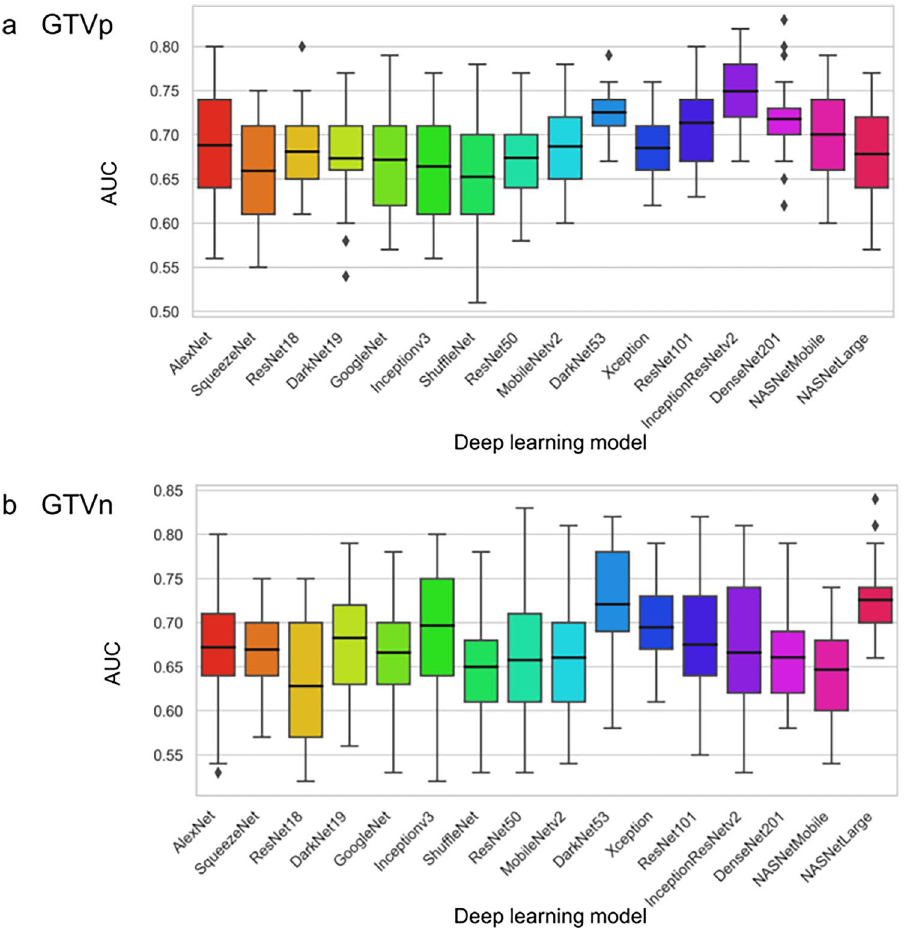
Figure 3. Average performance of 16 CNNs for predicting radiation-induced gross tumor volume (GTV) regression prior to treatment using all combinations of five deep feature selection algorithms and five machine learning algorithms (25 models per CNN). Performance was evaluated by the median area under the receiver operating characteristic (ROC) curve. ( a ) Predictive performance for primary gross tumor volume (GTVp) regression. ( b ) Predictive performance for nodal gross tumor volume (GTVn)